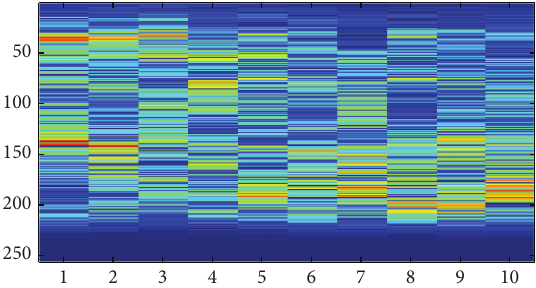
Figure 6: The column basis matrix obtained by 2DNMF.